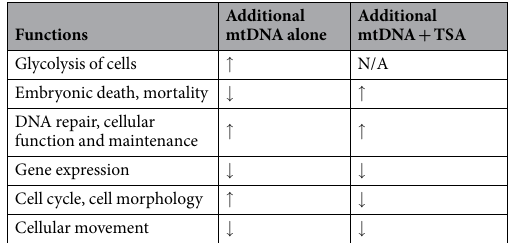
Table 2. List of biological functions affected by additional mtDNA with or without TSA when compared with SCNT blastocysts derived from depleted cells in the presence of